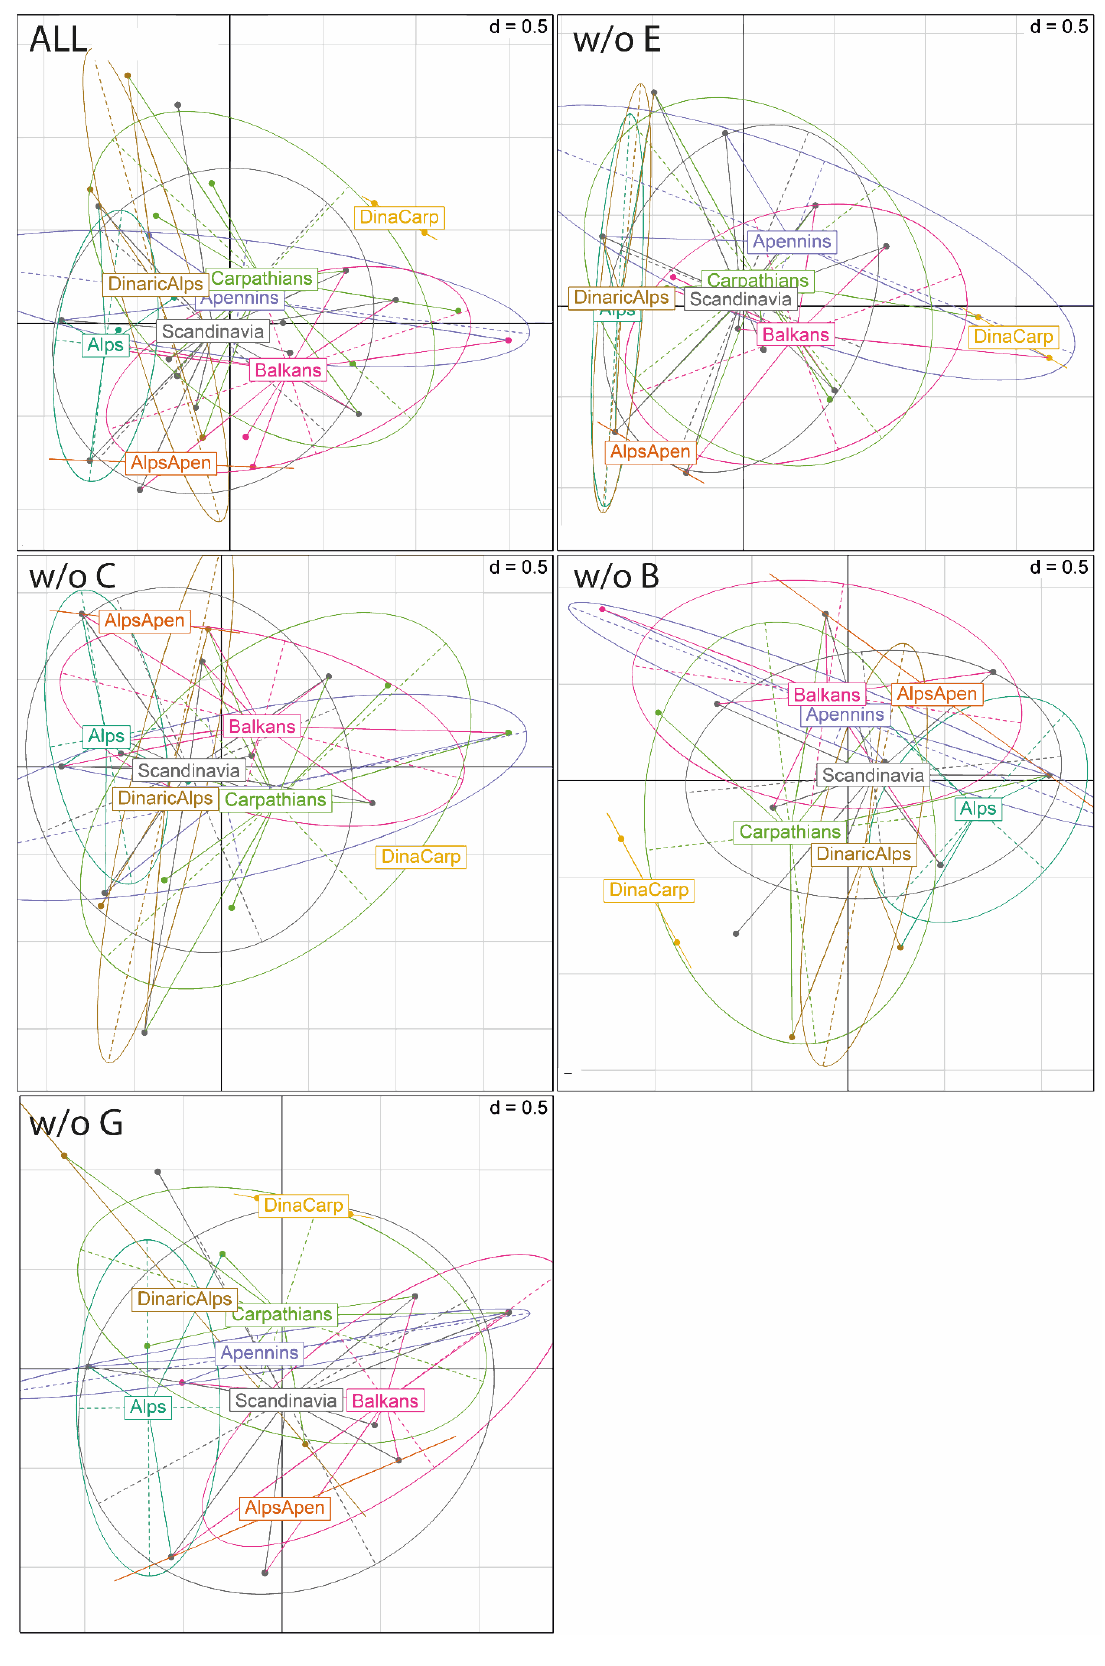
Figure A6. Graphic representation of individuals classed by study area for all five MCAs.